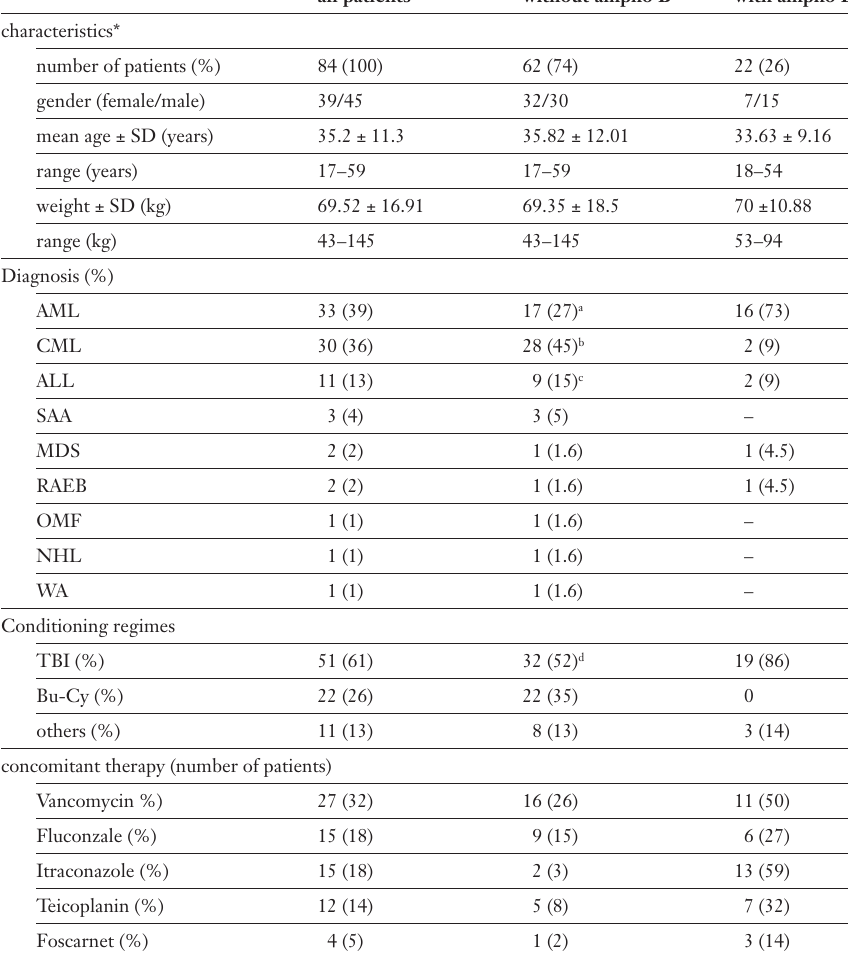
Table 1 Characteristics of all patients compared to treatment group with and without ampho- tericin